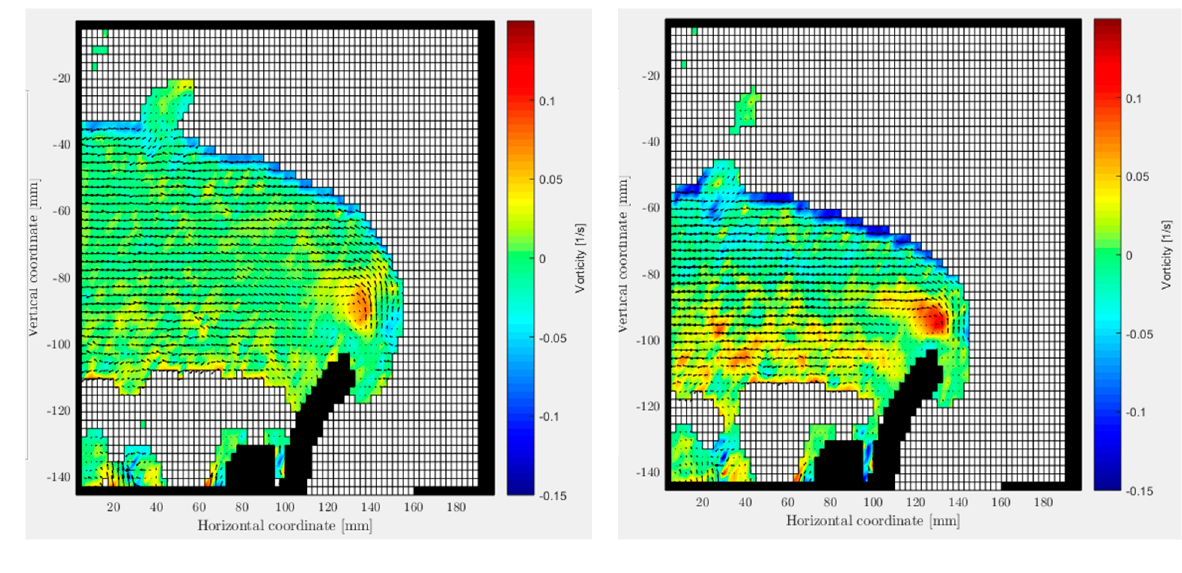
Figure 10. Vorticity field results showing the effects of an inflow condition of ( a ) 1 m. s − 1 and ( b ) 2 m. s − 1 on the exhaust smoke dispersion, for the North-East wind direction.